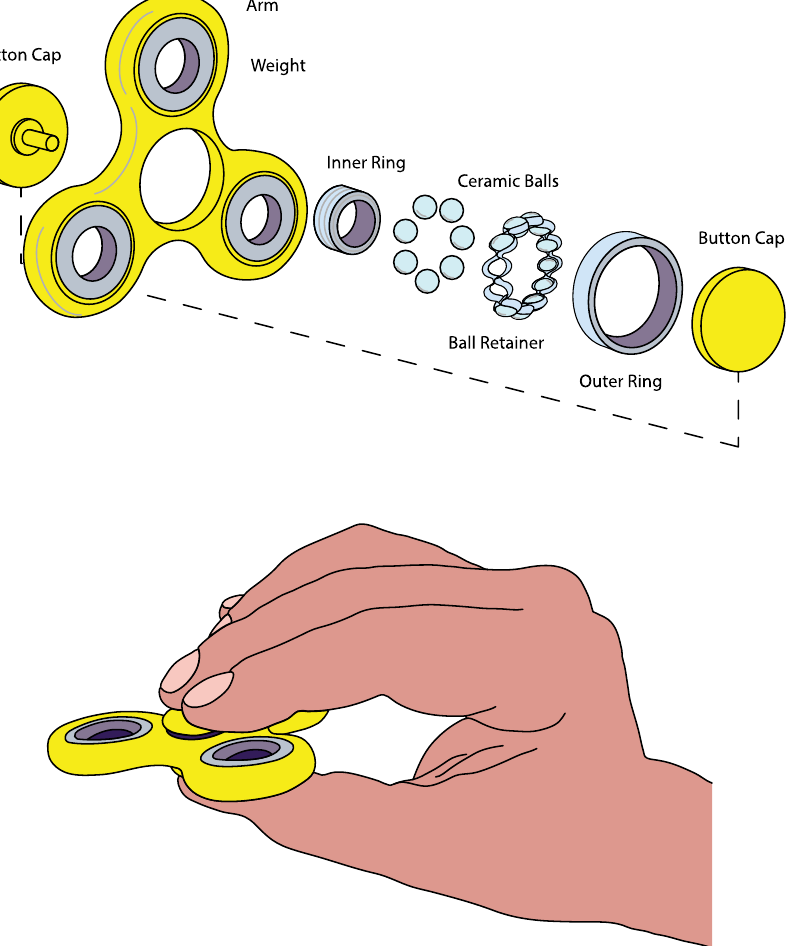
Figure 1. A diagram of Fidget Spinner and grip. In the upper panel it is possible to see the components of the fidget spinner, including the ball-bearing mechanism formed by the two rings interposed by ceramic balls, held together by a retainer. The bottom panel illustrates the way that the fidget spinner was asked to be held during the experiment, with the index and third fingers at the top and thumb at the